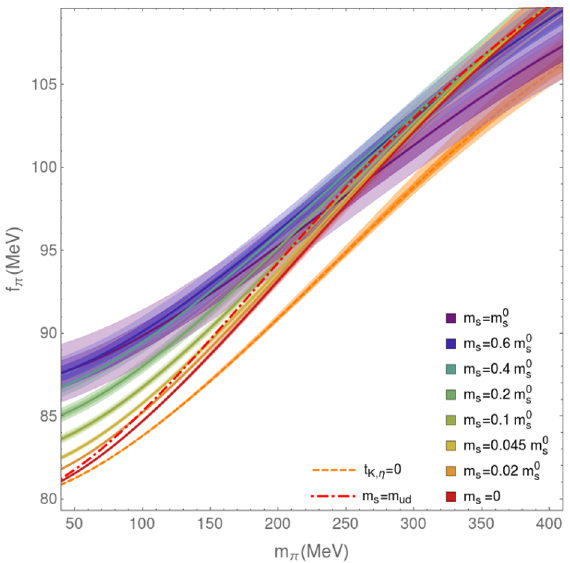
Figure 16 . The pion decay constant, f (cid:25) , see eq. (2.9), as a function of m (cid:25) for di(cid:11)erent strange- quark masses, m s . The continuous and dot-dashed red lines represent the solution for the pion decay constant from Fit IV at di(cid:11)erent values of m s and in the symmetric line, while the orange-dashed curve is the solution when t K;(cid:17) =